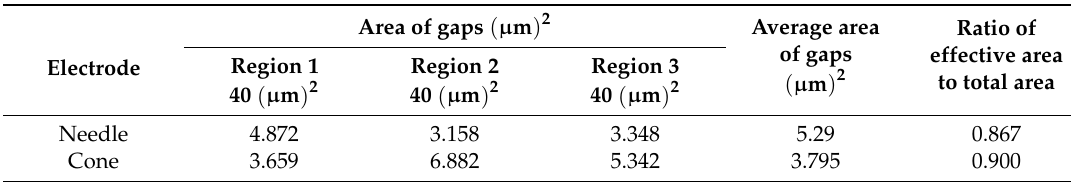
Table 4. Calculations of fibers’ effective area.